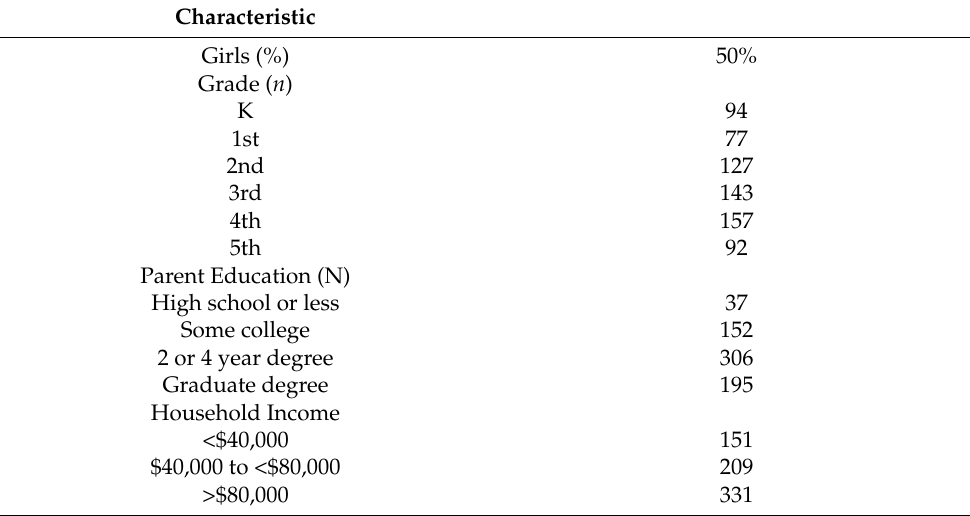
Table 1. Descriptive characteristics of the sample (N =